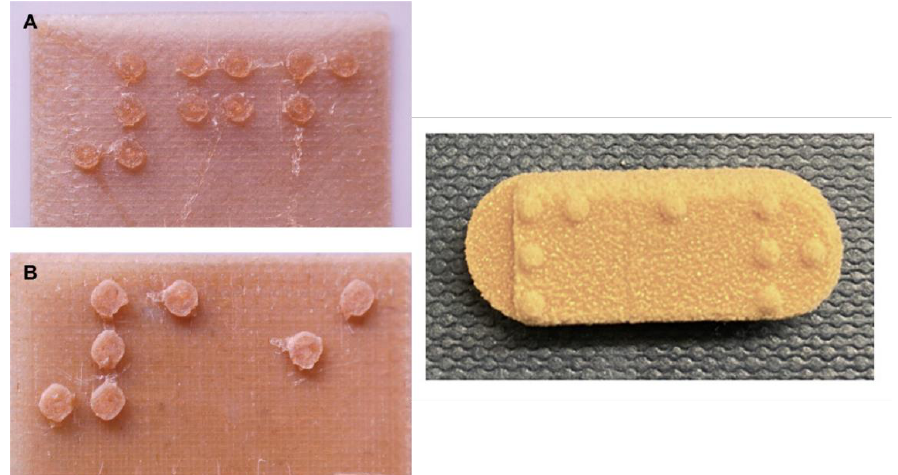
Figure 4. 3D-printed oral films ( left ) and tablet ( right ) containing Braille characters for identification of the dosage form by visually impaired patients. The respective diameters of the Braille patterns are 1.6 mm ( A ), 2 mm ( B ), and 1.5 mm ( right ) [51,52].